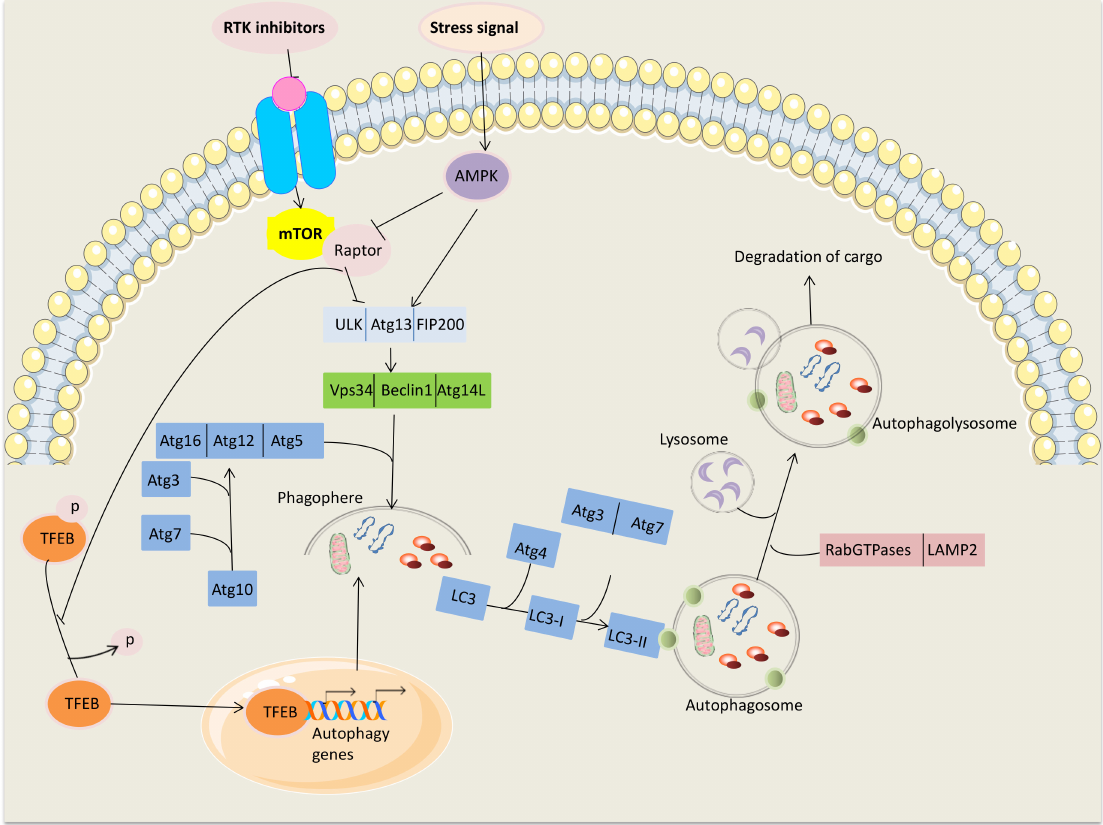
Figure 1. TheUnc-51likeautophagyactivatingkinase(ULK1)serinethreoninekinasecomplex, involving ULK1, FIP200, and ATG13, acts in the initiation process, phosphorylating multiple downstream factors. Then, the complex involving Beclin1, VPS34, a class III phosphatidylinositol-3-kinase (PI3K) and ATG14 acts in autophagosome nucleation step. During the maturation step, the ATG7 and ATG10 conjugate ATG5 to ATG12, and ATG7 and ATG3 conjugate microtubule-associated protein 1 light chain 3 (LC3) (ATG8) to the lipid phosphatidylethanolamine (PE). The ATG5-ATG12 conjugate forms a complex with ATG16, and the ATG5-ATG12-ATG16 complex gets anchored onto phosphoinositol 3-phosphate generated by VPS34 on emerging autophagosomal membranes through WD repeat domain, phosphoinositide-interacting 2b (WIPI-2b). The complex is e ffi cient for the LC3 conjugation system. LC3 is first conjugated with PE. ATG4 plays a role in lipoxidating LC3 to LC3-I and exposes the C-terminal glycine of LC3 for the subsequent conjugation of PE. PE is conjugated to the C-terminal glycine of LC3-I, and this conjugation needs to be catalyzed by the E1-like enzyme ATG7 and the